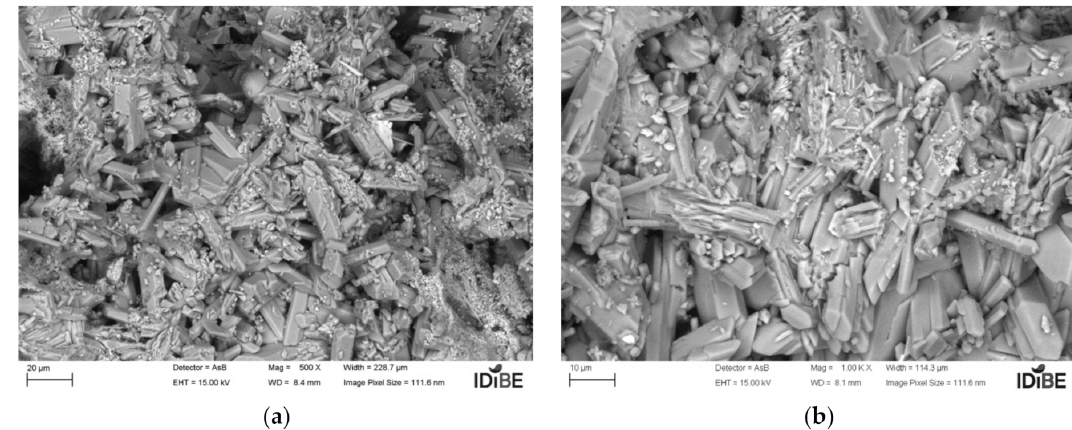
Figure 9. Micrograph of the 0.2% polycarbonate salt compound (lot TAR1): ( a ) 20 µ m; ( b ) 10 µ m (source: the